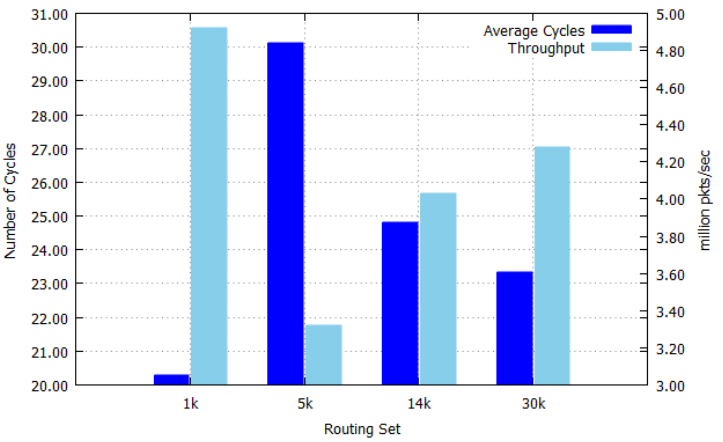
Figure 9. Relationship between average number of cycles and